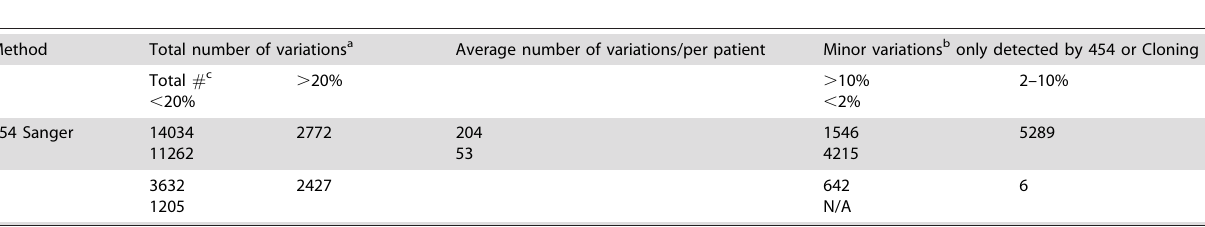
Table 1. Comparison of the detected variations by 454 and Sanger Clone-based sequencing methods.